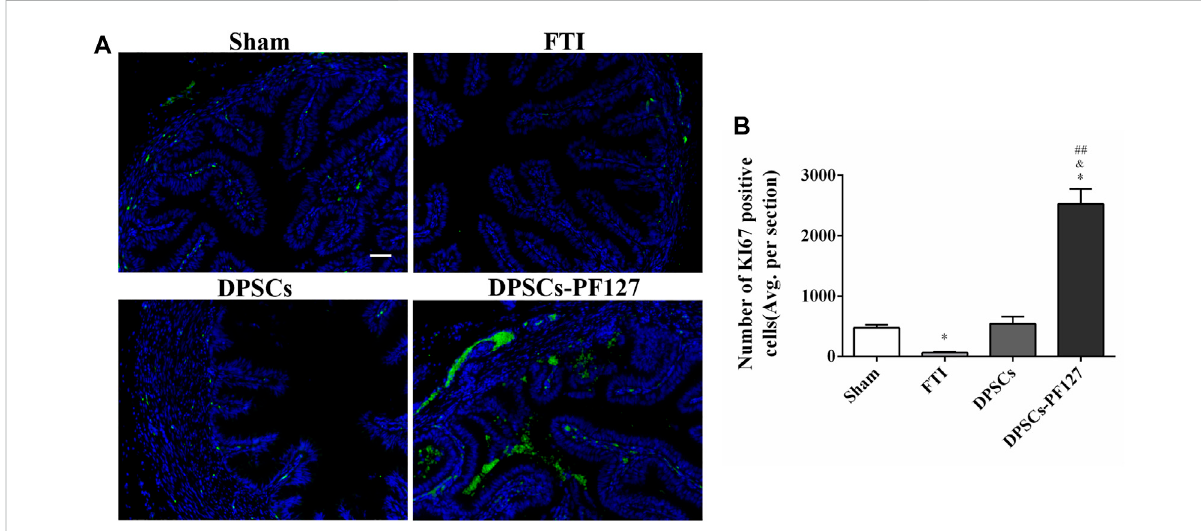
FIGURE 8 DPSCs-PF127enhancescellproliferationoftheFTat4 weeksafterinjury. (A) Immuno fl uorescencestainingforKI67(green)ofsectionsfromthe FT in each group. Scale bar: 50 µm. (B) Quantitative estimation of KI67-positive cells from three independent sections. All data represent Mean values ±SEM. * p < .05 versus the Sham group. & p < .05 versus the FTI group. ## p < .01 versus the DPSCs group.